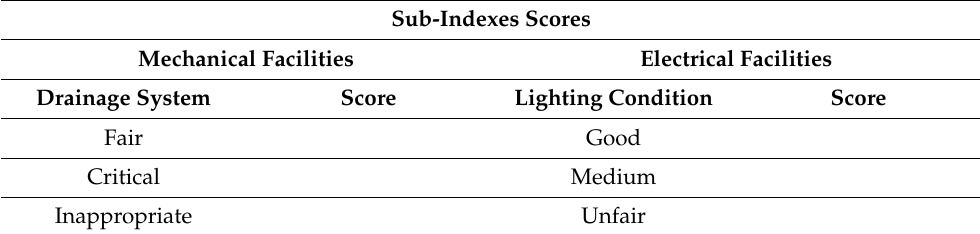
Table A9. Scores of sub-indexes in facilities index.